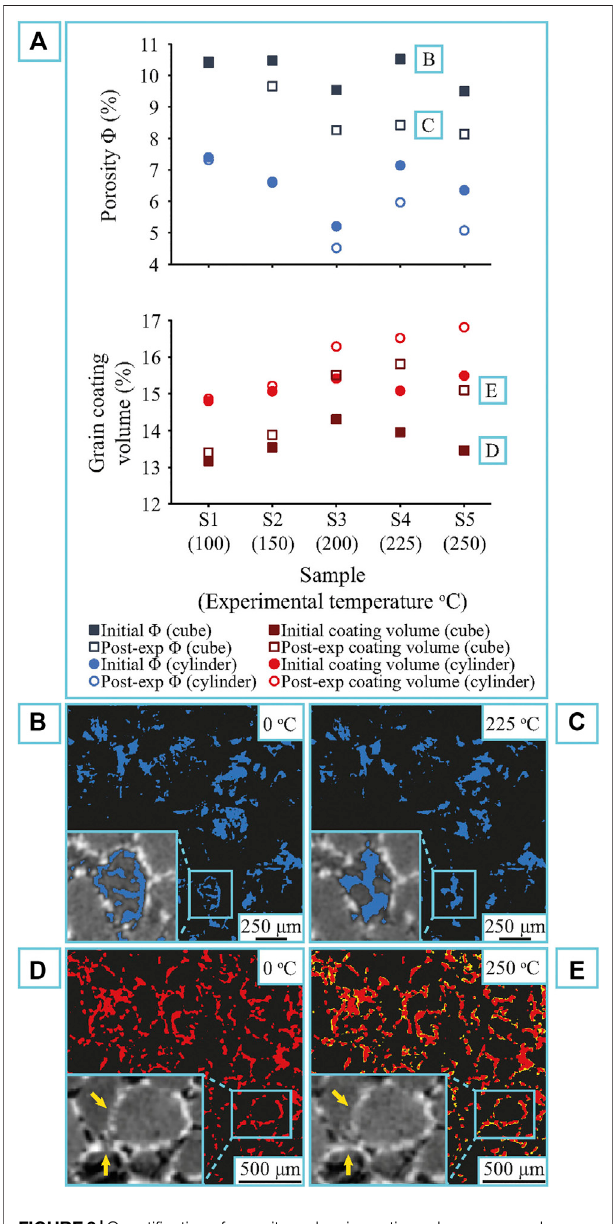
FIGURE3| Quanti fi cationofporosityandgraincoatingvolume,pre-and post-reaction, of samples S1-S5. (A) Porosity and grain coating volumetric change of the cylindrical and cubic (500 voxel 3 ) subvolumes of each sample/ temperature. Signi fi cant porosity reduction and grain coating volume increaseoccursattheexperimental temperaturesof200,225and250 ° C.The grain coating volumetric increase corresponds to the stabilization of porosity reduction at temperatures higher than 200 ° C. (B) 2D slice of the thresholded porosity phase (blue) of sample S4 before the experiment. (C) 2D slice of the thresholded porosity phase of sample S4 after the experiment at 225 ° C showing the porosity decrease. Note the development of secondary porosity due to feldspar dissolution. (D) Initial grain coating volume (red). (E) Final grain coating volume (yellow) after the hydrothermal treatment at 250 ° C. The newly precipitated phase contributes to the increase of the thickness and continuity (yellow arrows) of the initial coatings.